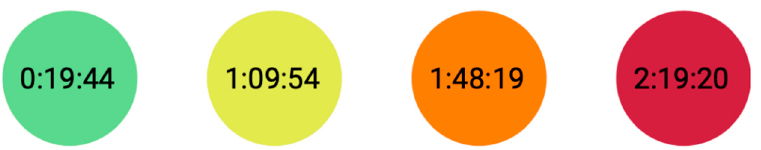
Figure 3. Floating widget’s colors when the user surpasses 50% (dark yellow), 75% (orange) and 100% (red-maroon) of the defined maximum total usage time, respectively. Before achieving 50% of the defined usage time, the widget is predefined to appear as green. For this example, a two-hour goal by the user was considered.